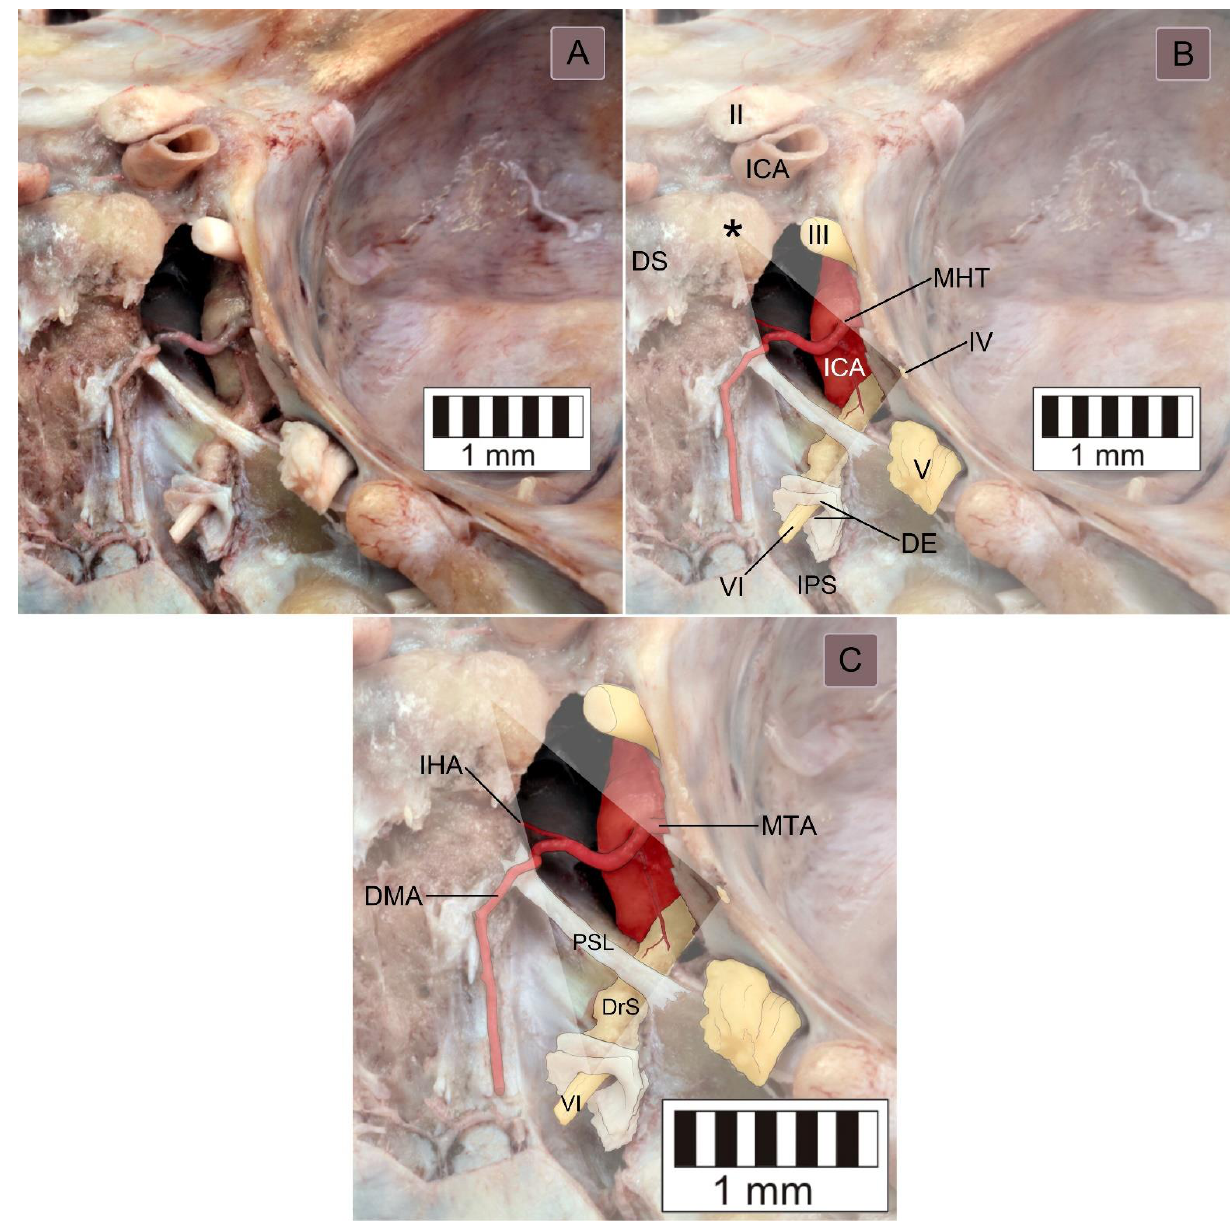
Figure 2. The topographical relationships within the inferomedial paraclival triangle. ( A ) Posterosuperior view of the right paraclival area of a wet anatomical specimen. The arteries were injected with red resin. The petroclival dura, including the posterior wall of the cavernous sinus, was removed. ( B ) The same photograph with neurovascular structures digitally color-enhanced to improve clarity and understanding of the topographical relationships. The borders of the inferomedial paraclival triangle were delineated between the posterior clinoid process (marked by a black asterisk), the dural entry point of the abducens nerve (DE) and the dural entry point of the trochlear nerve (IV). The gulfar segment of the abducens nerve (VI) is located between the dural entry point and the posterior border of the petrosphenoidal ligament. The opening of the inferior petrosal sinus (IPS) is visible below the abducens nerve’s dural entrance. The posterior genu of the intracavernous carotid artery and meningohypophyseal trunk are exposed within the triangle. II = optic nerve; III = oculomotor nerve; V = trigeminal nerve; DS = dorsum sellae; and ICA = internal carotid artery. ( C ) Magnification of ( B ) showing detailed topographical relationships within the inferomedial triangle. The dorsal meningeal artery (DMA) runs posterior and inferomedially. In this specimen, the course of the artery over the petrosphenoidal ligament (PSL) is atypical. The abducens nerve (VI) within the surrounding dural sleeve (DrS) is located at the confluence of the inferior and superior petrosal sinuses with the basilar plexus. IHA = inferior hypophyseal artery and MTA = medial tentorial artery.